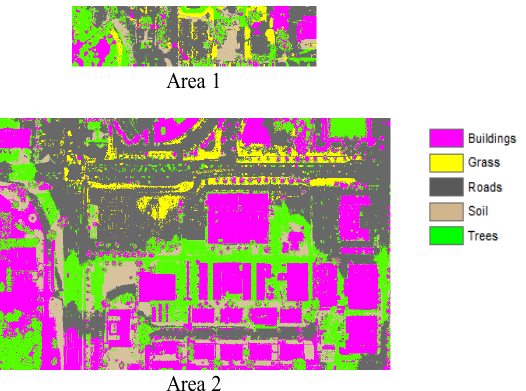
Figure 8. Classification Results of the Point Format Data after Filling the